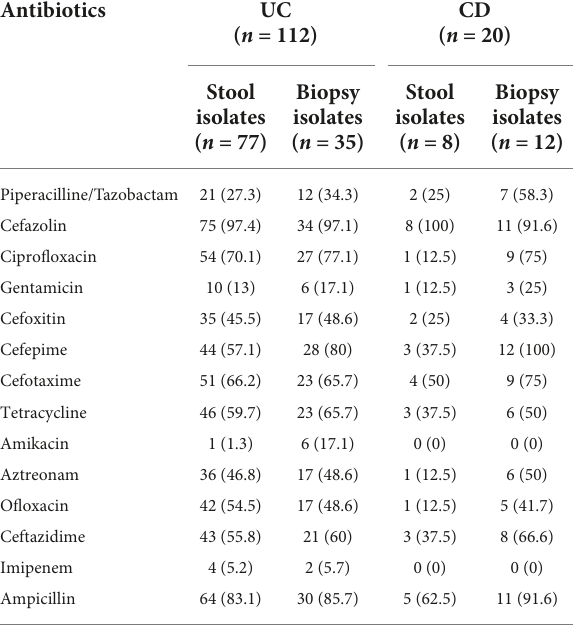
TABLE 1 Demographic data and clinical characteristics of the inflammatory bowel disease (IBD) patients. Characteristics